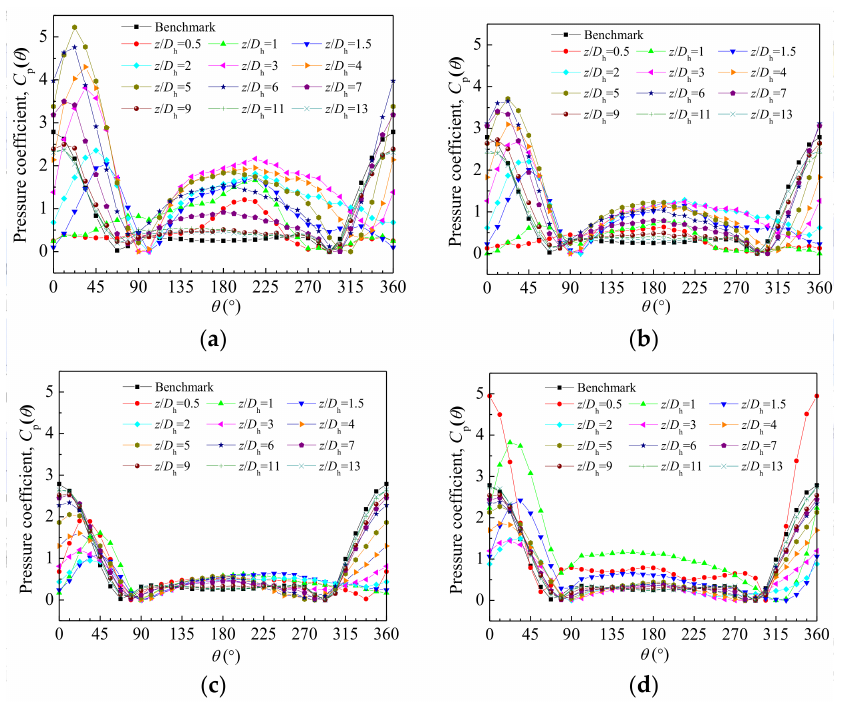
Figure 12. Pressure distributions at different positions at different R without vanes: ( a ) R = 0.150;